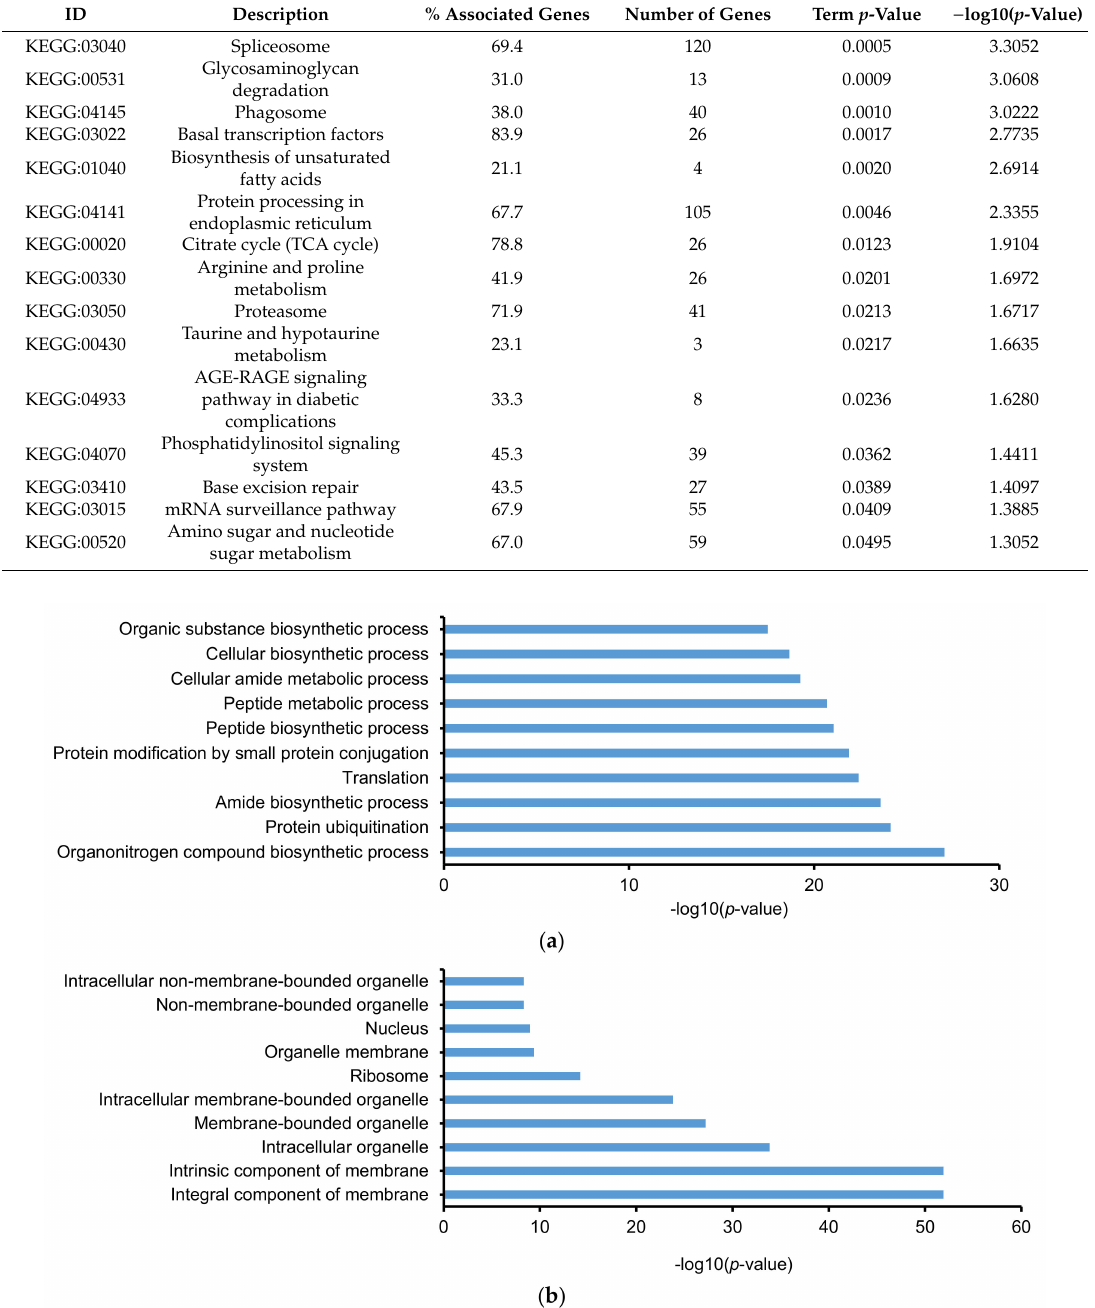
Table 1. Kyoto Encyclopedia of Gene and Genomes (KEGG) pathways involved in identified protein groups from E. huxleyi (CCMP371) using ClueGO.